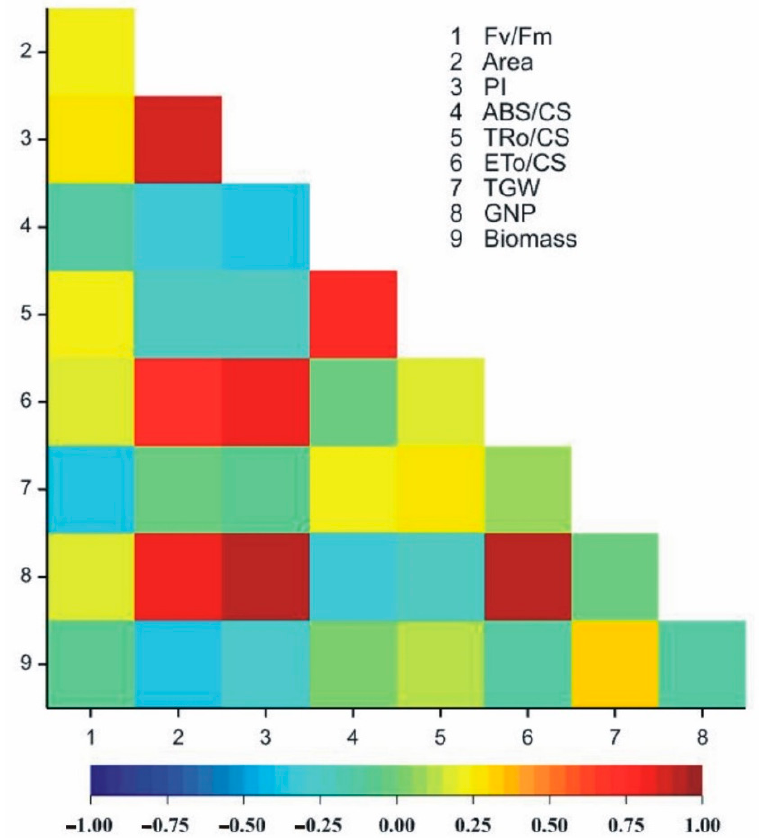
Figure 2. Heatmaps for Pearson’s correlation coefficients between observed traits (CF parameters, yield elements and biomass) for 32 barley DH lines. Table 4. Correlation coefficients between the first two canonical variables and original traits of barley DH lines. Trait First Canonical Variate, V 1 Second Canonical Variate, V 2 Fv/Fm − 0.042 −